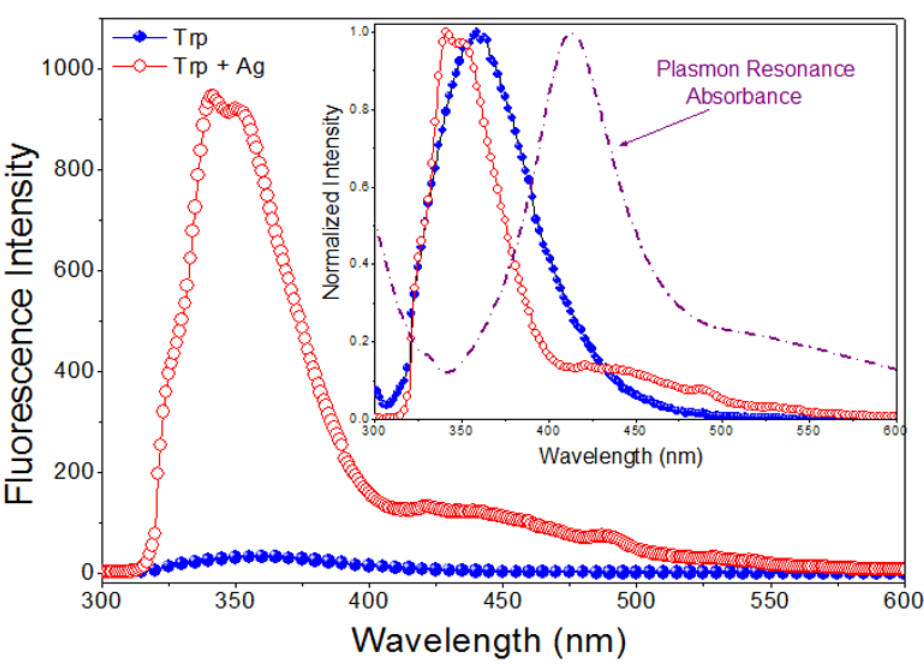
Figure 2. Metal-enhanced fluorescence caused by the silver nanoparticle colloid at 32 mg L -1 . The inset shows the normalized fluorescence spectra overlaid with the plasmon absorption